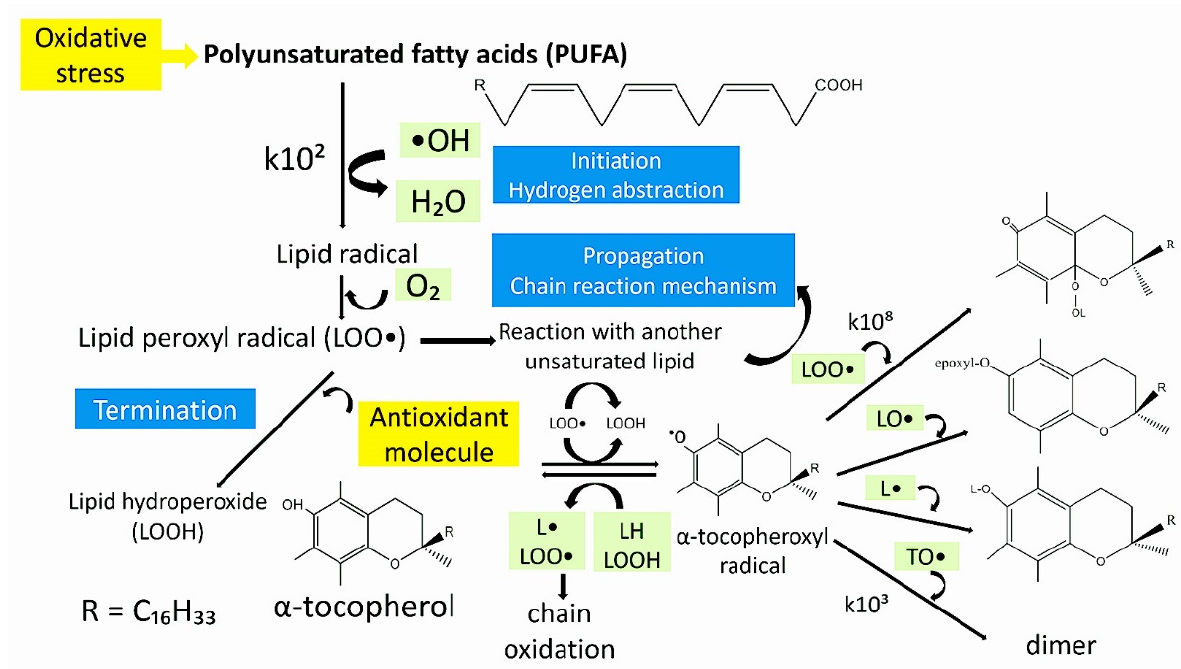
Figure 6. The reaction of α -tocopherol during the autoxidation of unsaturated lipids. LOOH-lipid hydroperoxide; LO • -lipid-alkoxyl radical; L • carbon-centered lipid radical; LOO • -lipid-peroxyl radical; TO • - α tocopheroxyl radical; k-rate constant in M − 1 s − 1 .